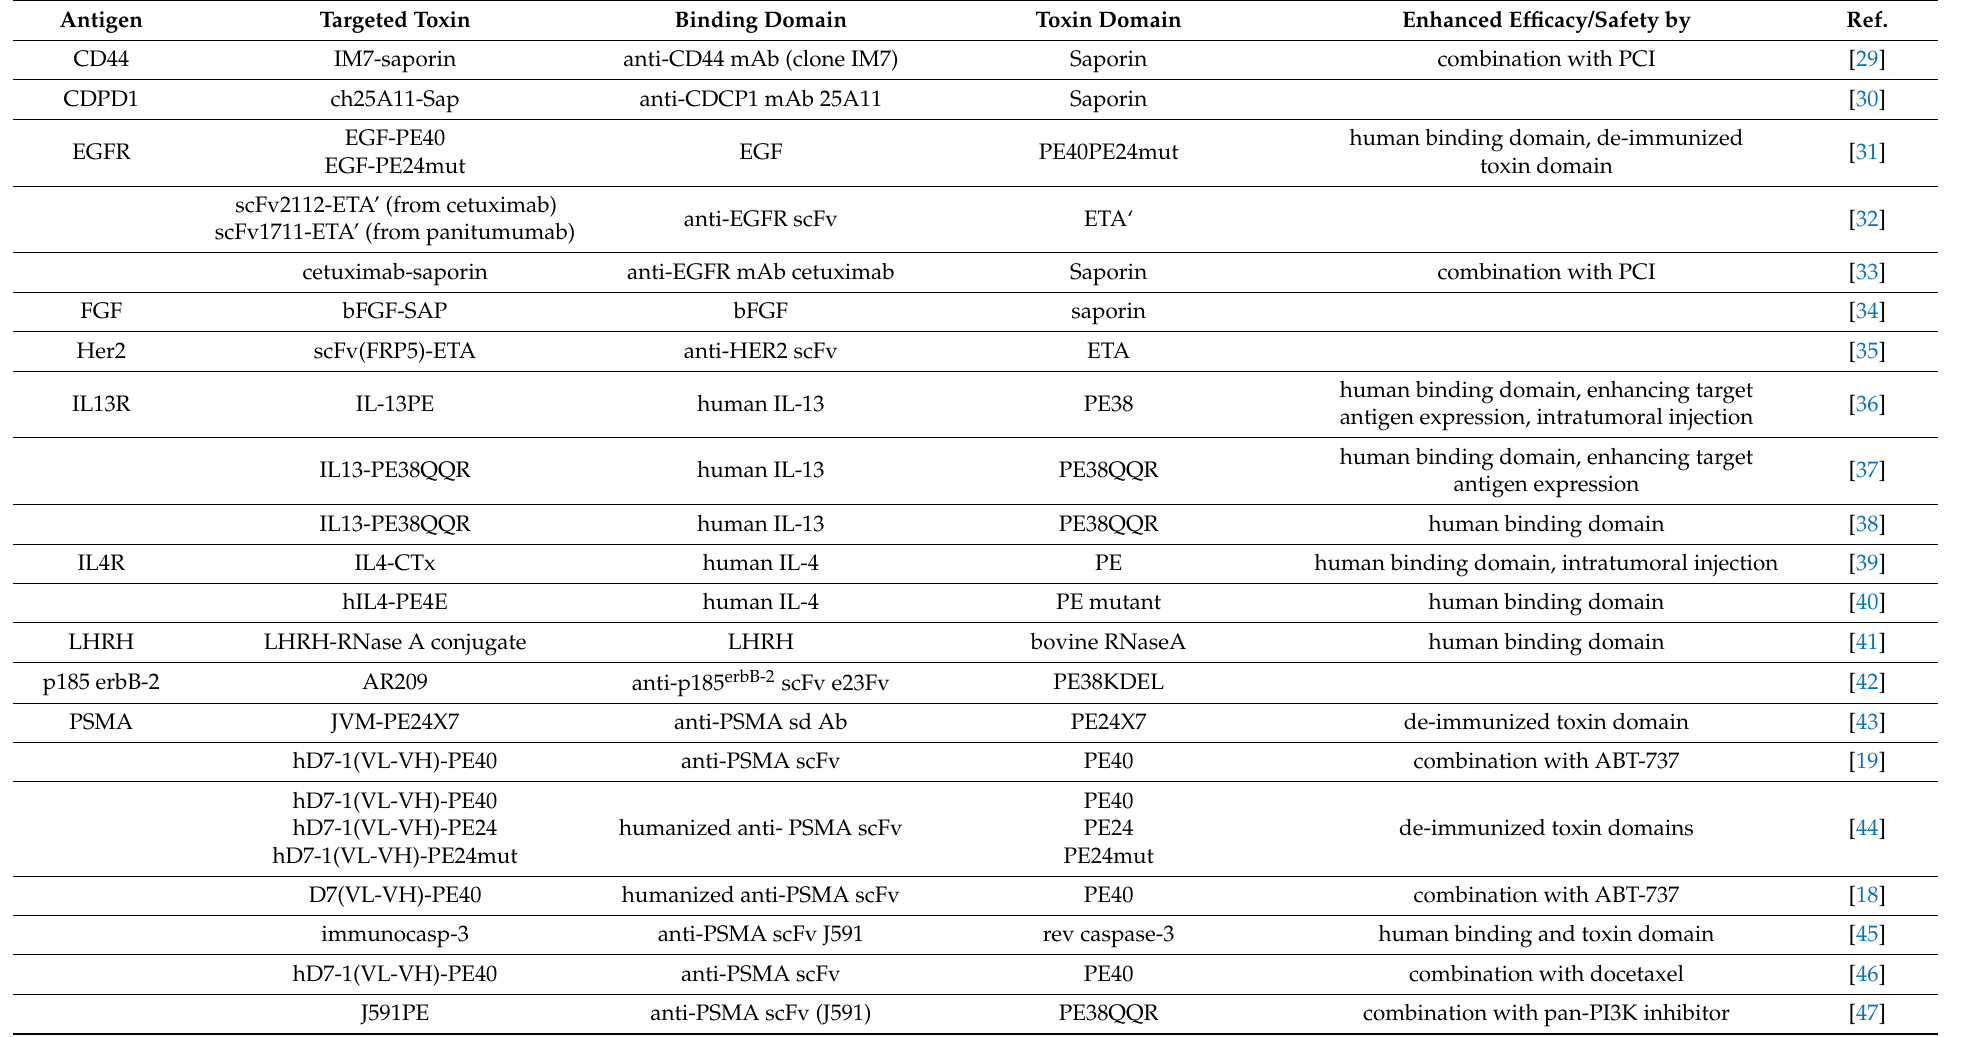
Table 1. Preclinical studies with targeted toxins against prostate